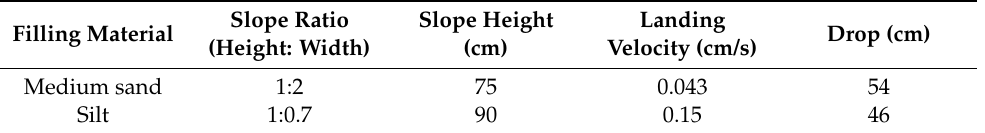
Table 2. Model test part working condition table.